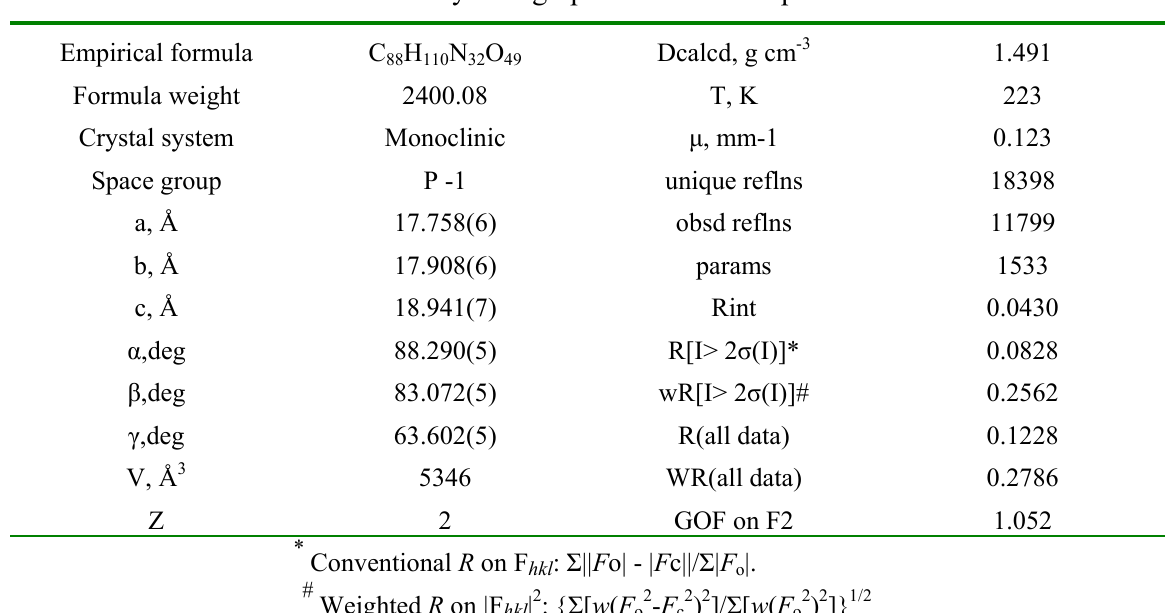
Table 2. Crystallographic data for complex 1